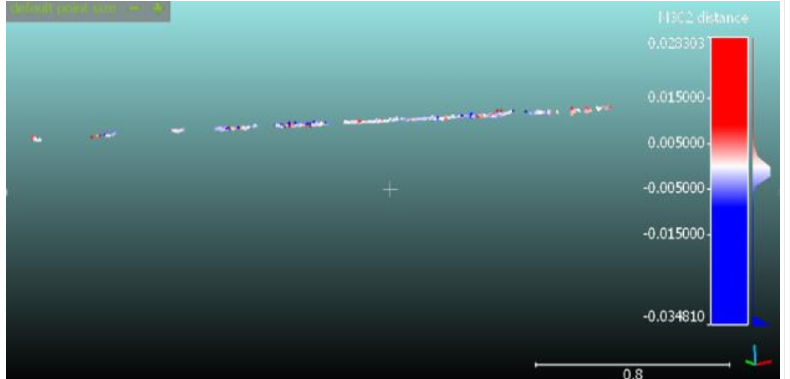
Figure 11. Comparison of edge points detected using the calibrated focal length and the original 3D edge in the point